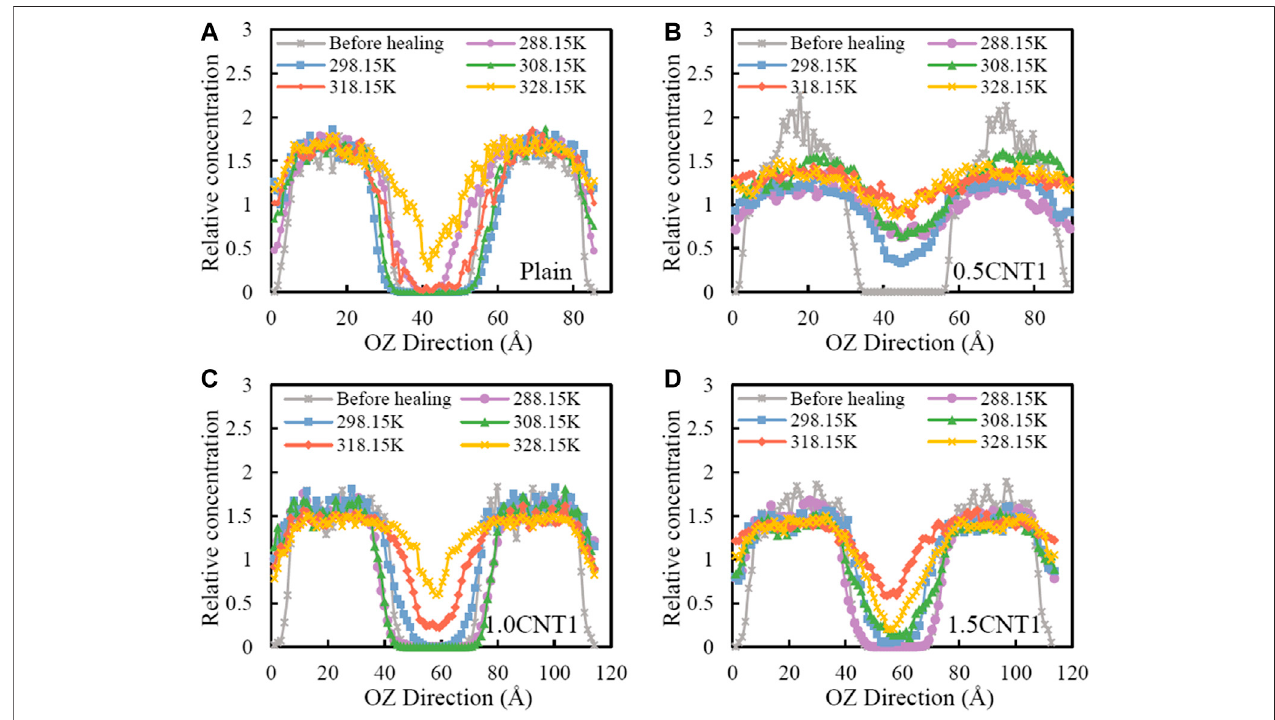
FIGURE 4 | Relative concentrations along OZ direction of the CNT1 modi fi ed PEN70 asphalt binders with different weight percentage: (A) plain; (B) 0.5% CNT1; (C) 1.0% CNT1; (D) 1.5% CNT1.